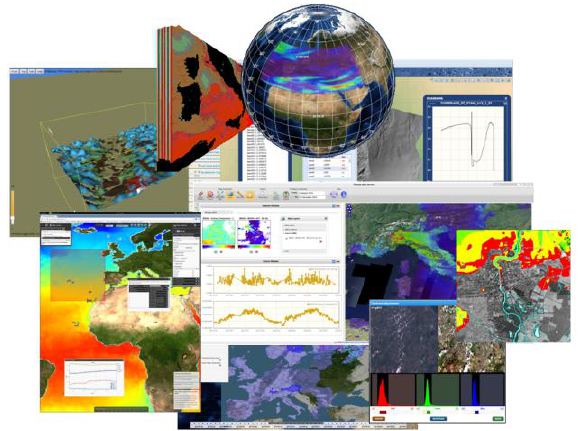
Figure 10. Screenshots of domain and task specific client